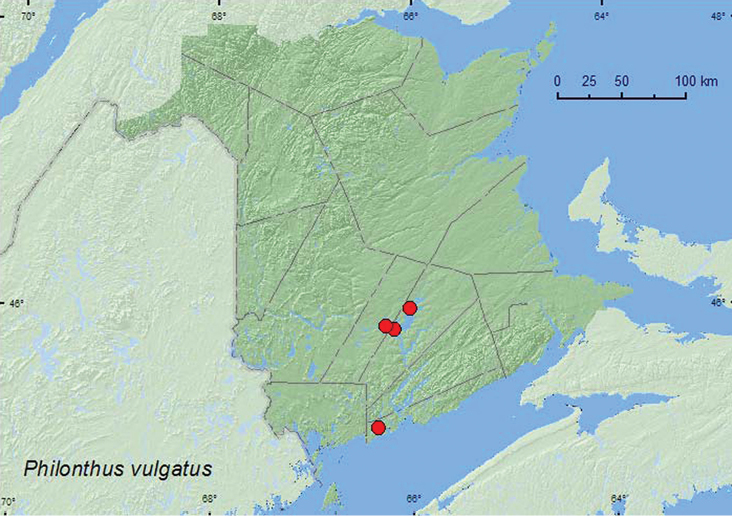
Collection localities in New Brunswick, Canada of Philonthus vulgatus.